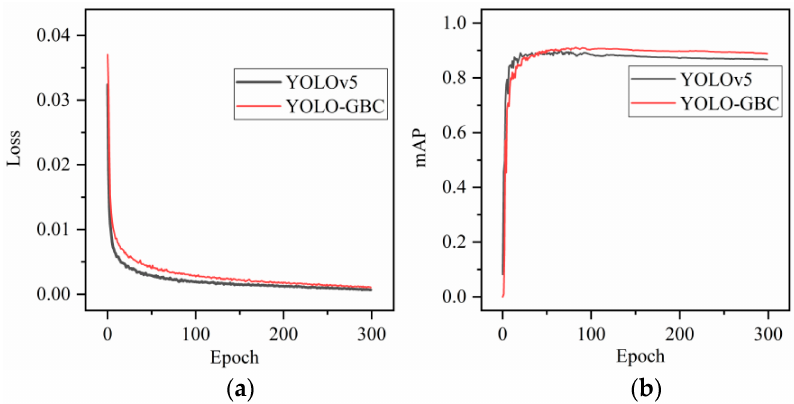
Figure 9. Network training result. ( a ) loss curve; ( b ) mAP curve.